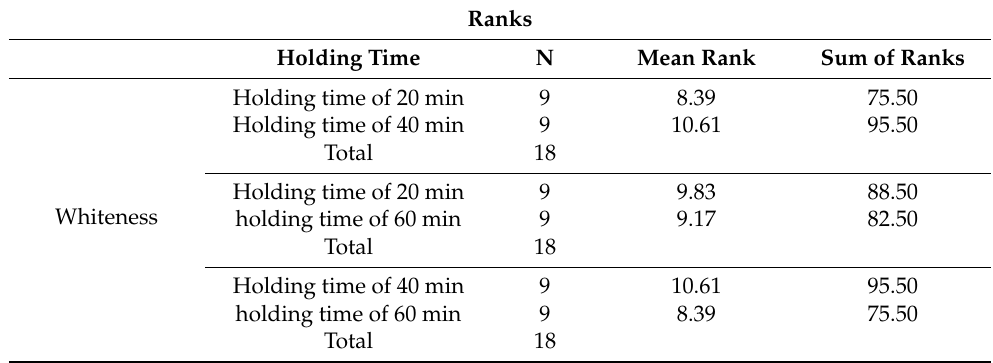
Table A2. Ranks table of Mann–Whitney U test for the whiteness, according to the holding